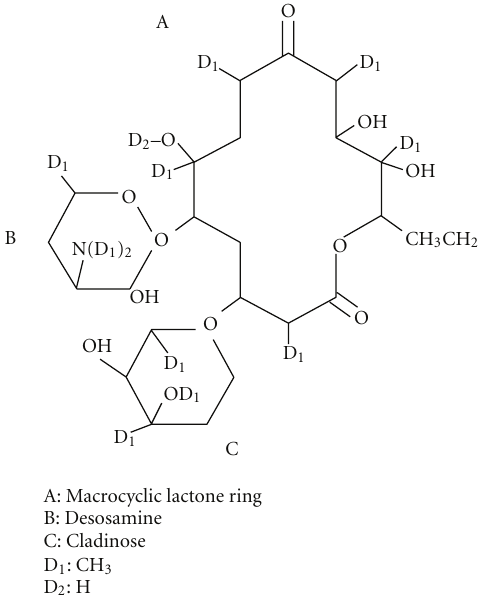
Figure 1: 14 member lactone rings of